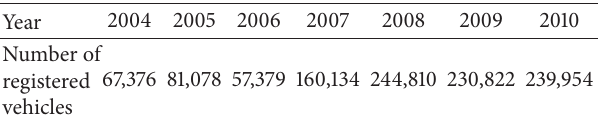
The regression equation